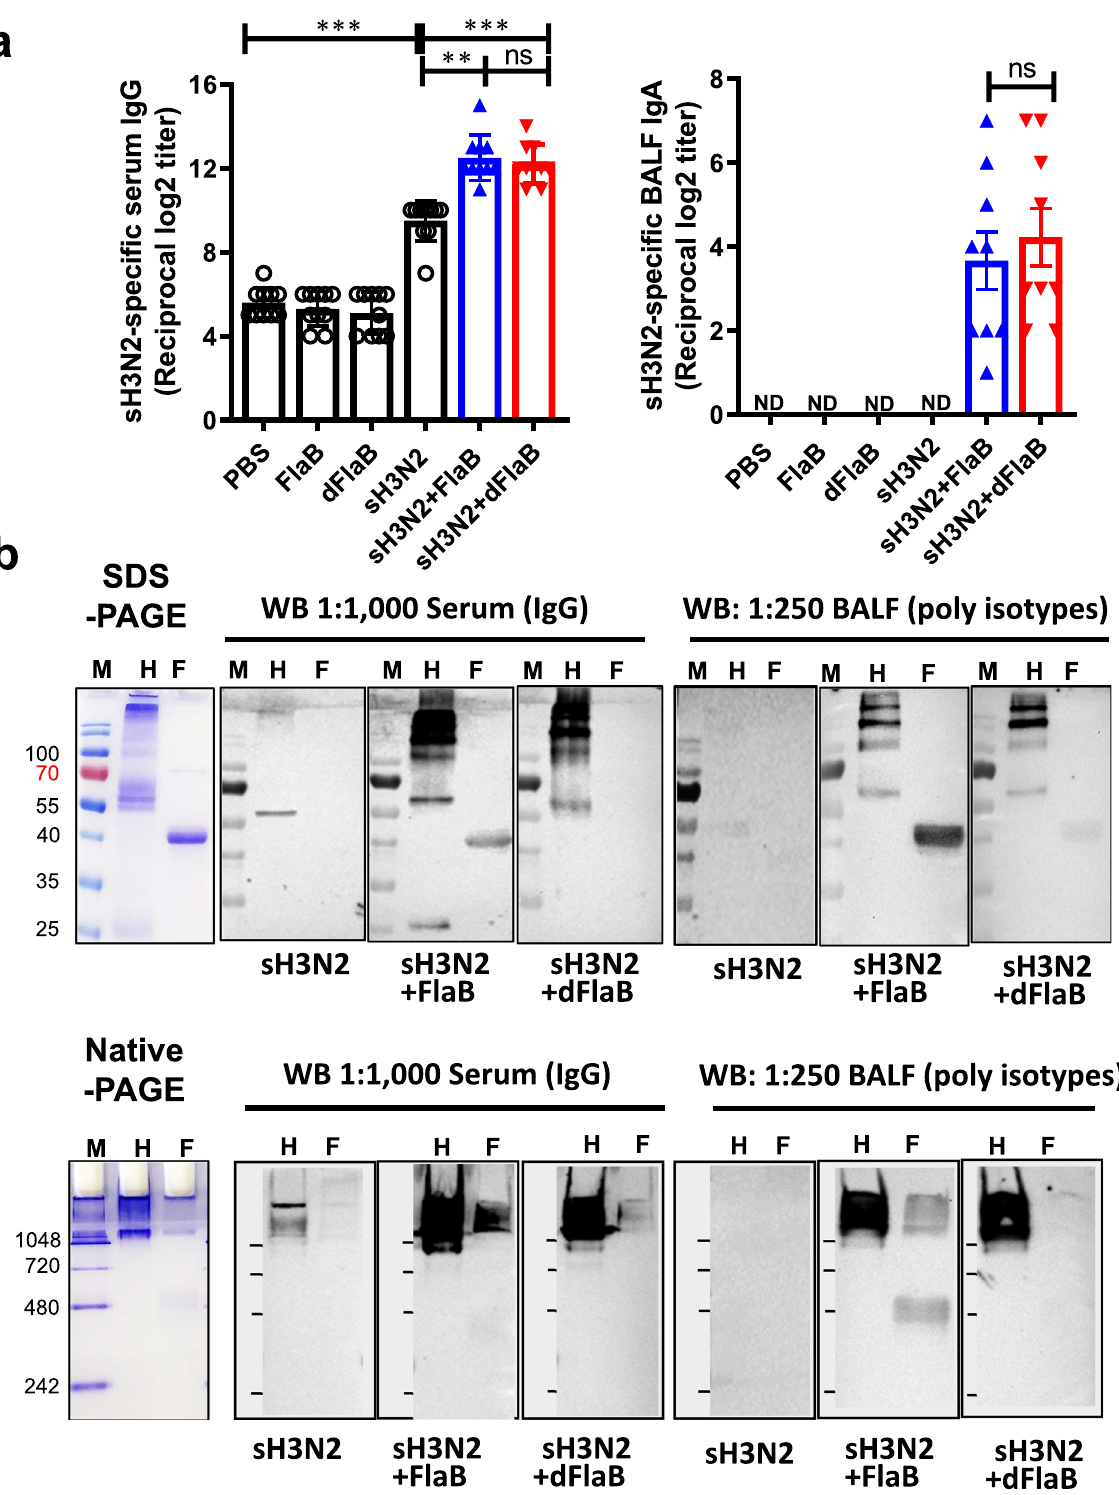
Fig. 5 The dFlaB has strong mucosal adjuvant activity without FlaB-speci fi c Ab induction. a Ag-speci fi c antibody response after intranasal vaccination. Groups ( n = 9 – 10) of mice were intranasally vaccinated with PBS (PBS), 4 μ g FlaB (FlaB), 4 μ g dFlaB (dFlaB), 1.5 μ g H3N2 A/ Switzerland/9715293/2013 NIB-88 split vaccine (sH3N2), 1.5 μ g sH3N2 plus 4 μ g FlaB (sH3N2 + FlaB), or 1.5 μ g sH3N2 plus 4 μ g dFlaB (sH3N2 + dFlaB) three times at two-week intervals. Two weeks after the last immunization, serum or BALF was collected and sH3N2-speci fi c serum IgG or BALF IgA titers were determined by ELISA. b Determination of sH3N2- or FlaB-speci fi c Ab production. Two weeks after the last immunization, serum or BALF was collected. SDS-denatured or non-denatured sH3N2 or FlaB was resolved by PAGE. The sH3N2- or FlaB- speci fi c Abs in the sera and BALF were probed by Western blotting analysis. Mann-Whitney test was used to compare two groups. *** P < 0.001; ns, non-signi fi cant; ND, not detected (under the detection limit); M, marker; H, sH3N2; F,